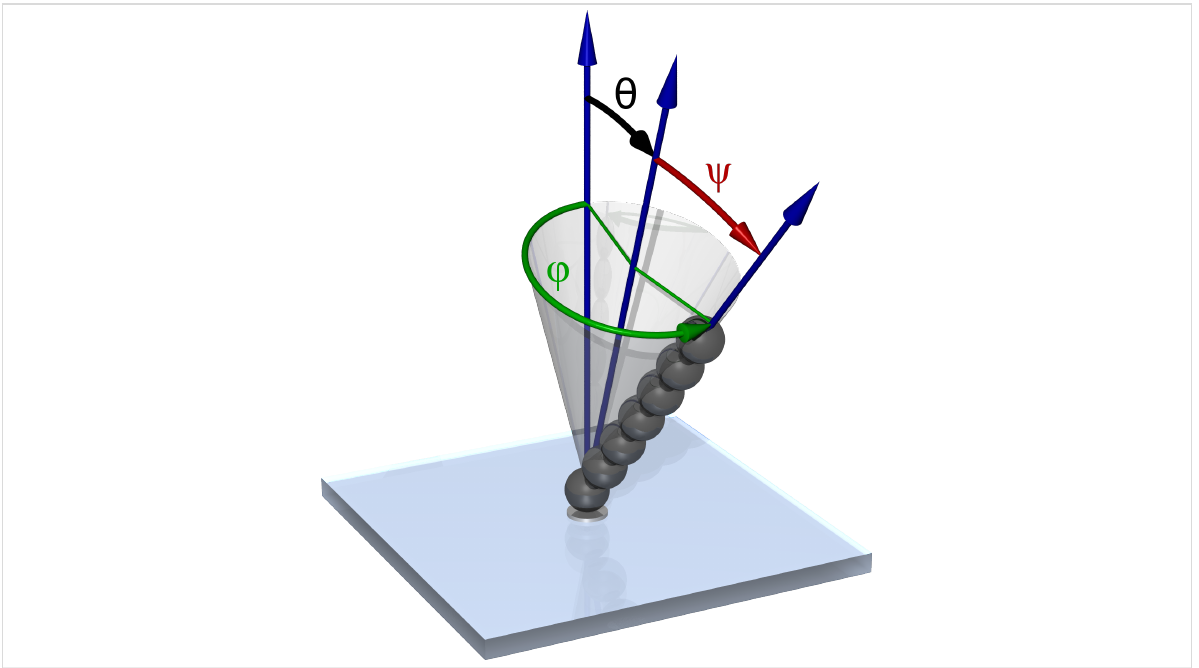
Figure 1: The artificial cilium is made of superparamagnetic beads. An external magnetic field is used to actuate the cilium in a periodic manner along a tilted inverted cone, defined by the tilt angle θ , semi-cone angle ψ and angular